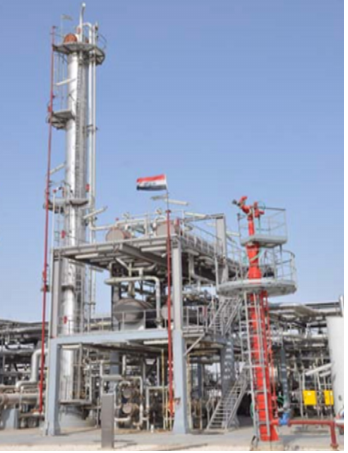
Figure 1. UNIT 7501 in Basrah Refinery.